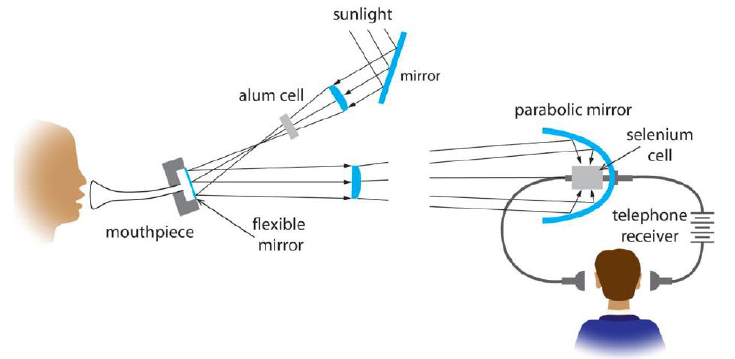
Figure 2. Scheme of the photophone setup, the first optical communication device created by Alexander Graham Bell and his assistant. Reproduced with permission from [68].